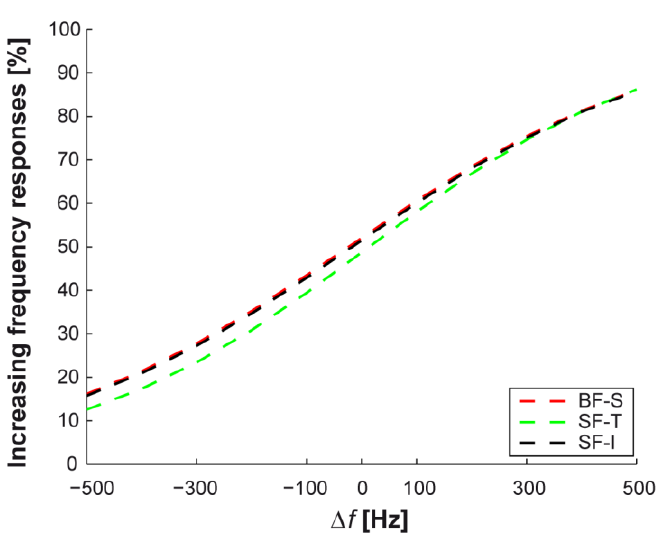
Figure 11. Comparison of the logistic fit of psychometric curves for all configurations. Comparison of logistic fit curves over the whole range of frequency variation. The curves are similar for all three experimented configurations.